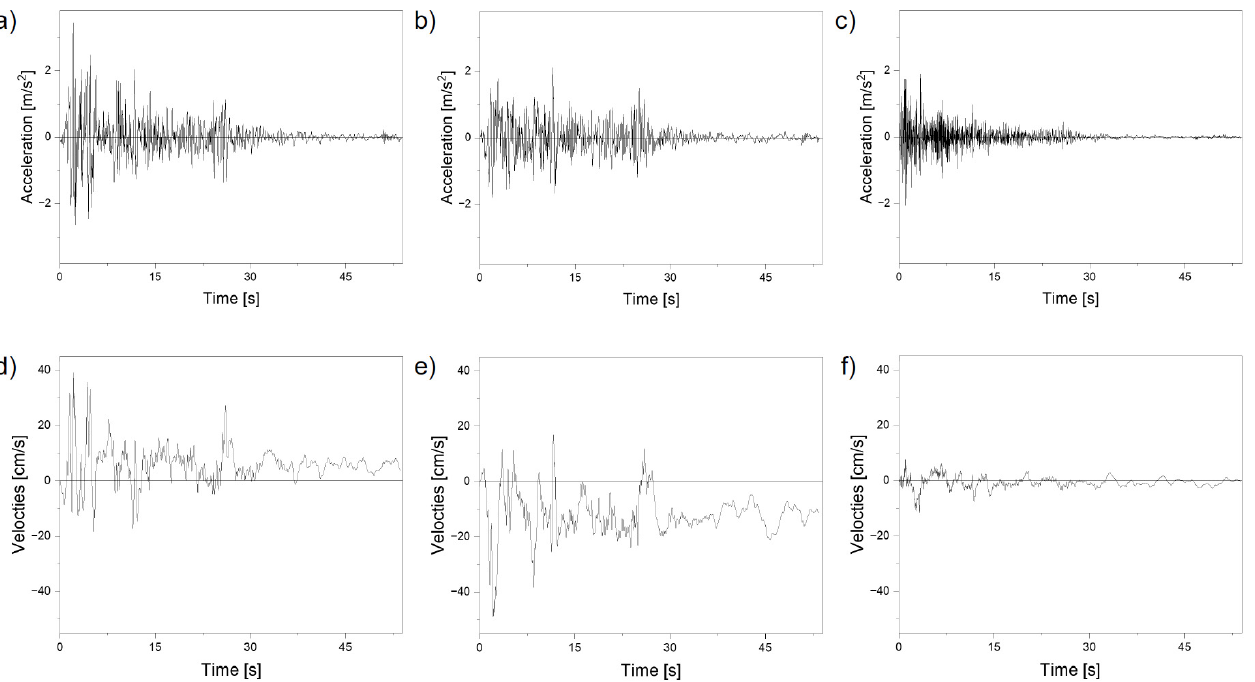
Figure 11. Seismic records from El Centro 1940 on the direction of accelerations: ( a ) X-NS, ( b ) Y-EW, ( c ) Z-UP; and velocities of ( d ) X-NS, ( e ) Y-EW, ( f ) Z-UP.